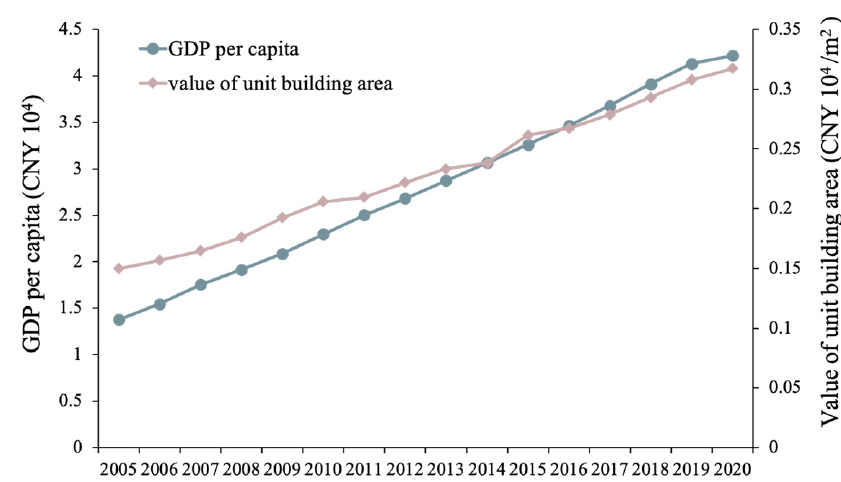
Figure 5. GDP per capita and value of unit building area in China from 2005 to 2020.